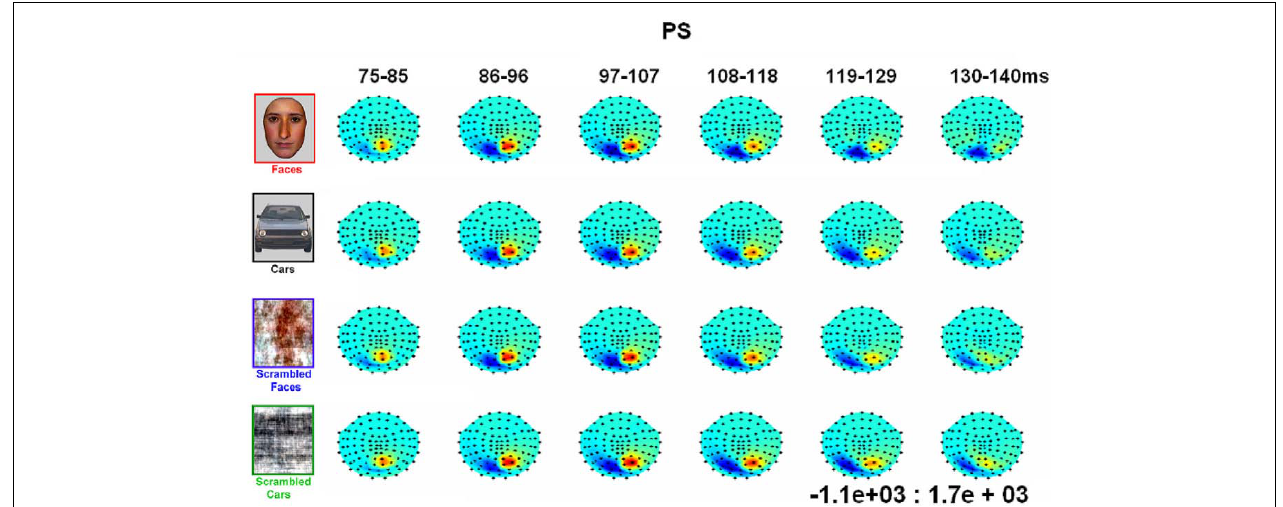
FIGUREA5 | Evolution of magnetic fields evoked by visual stimulation as recorded by 102 magnetometers for patient PS averaged across time windows around the M100 component.